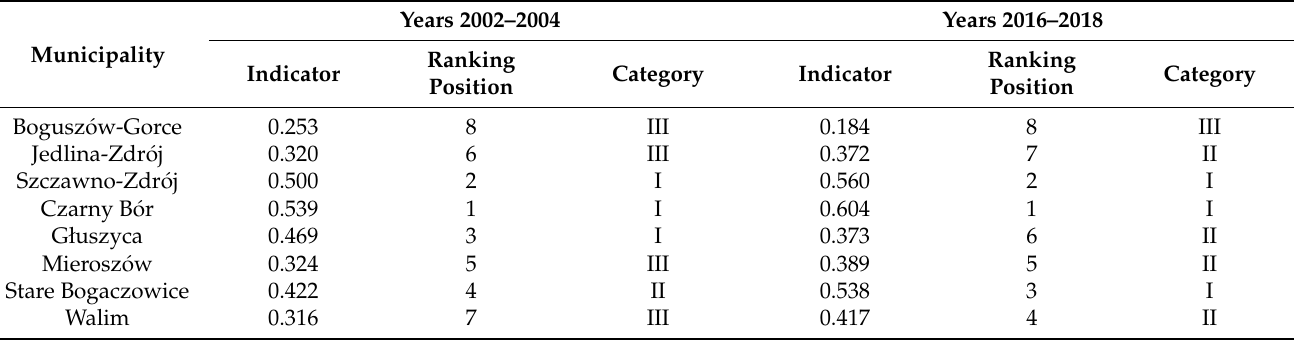
Table 3. Indicators of social development potential in municipalities of Wałbrzych County calculated using zero unitarization method.